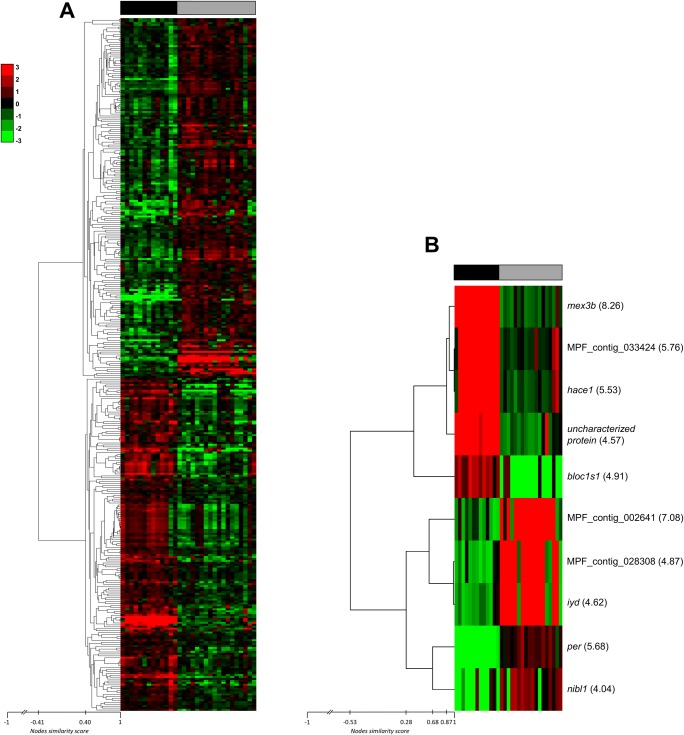
Heatmaps showing differentially expressed genes between F1 and F7+ populations.(A) Unsupervised hierarchical cluster analysis of 358 differentially expressed genes (p < 0.05) between populations. The dendrogram on the left represents gene correlation distances between the genes. (B) Unsupervised hierarchical cluster analysis of the 10 most differentially expressed genes (p < 0.05) with a log(2)FC >4, between populations. Gene abbreviated name and log(2)FC are shown between parentheses on the right. In both parts of the figure, red color indicates over-expression, and green color indicates under-expression while black is used for median expression. Top bar indicates the origin of the samples: black for F7+ samples and gray for F1 ones. Node similarity score bars represents the similarity between tree branches. It ranges from 1 (identical) to -1 (opposites), while 0 means they are completely uncorrelated.